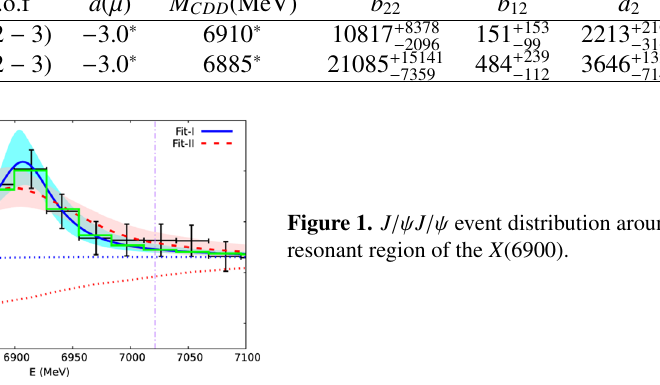
Table 5. Resonance poles of the X (6900) and its properties.